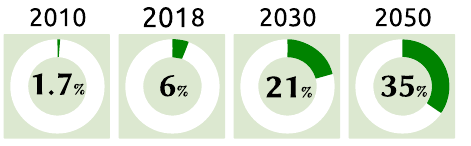
Figure 1. Wind power in total generation mix: onshore and offshore wind generation